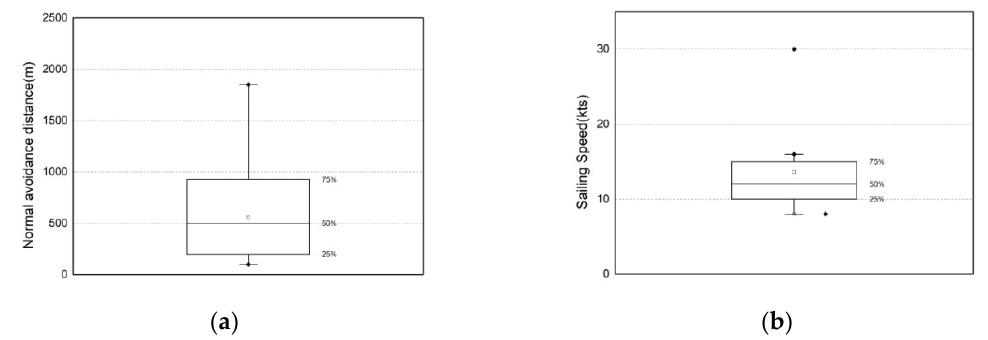
Figure 5. Box charts of survey responses from 19 captains of ocean-going fishing vessels: ( a ) normal collision avoidance distance and ( b ) average speed.